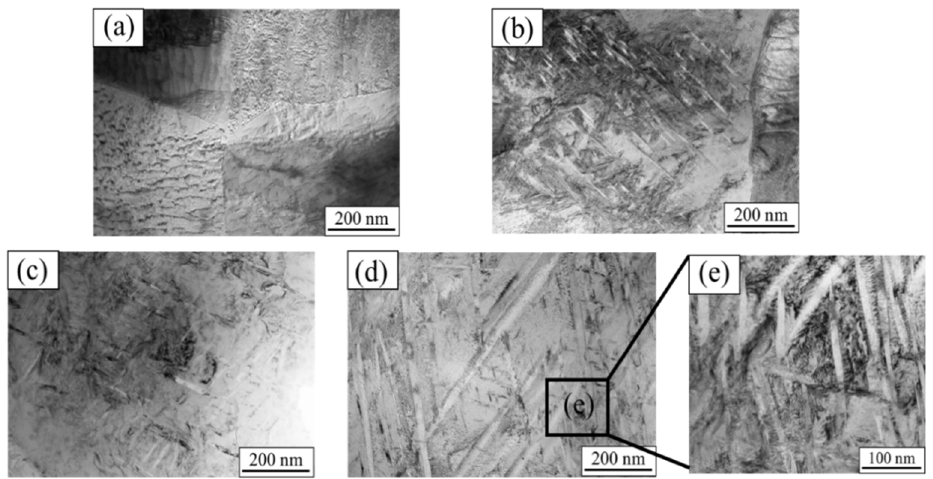
Figure 9. Ti-1023 TEM images of torsional region at different temperatures: ( a ) original tissue; ( b ) 500 °c; ( c ) 700 °c; ( d ) 900 °c; ( e ) figure ( d ) frame-selection magnification graph.